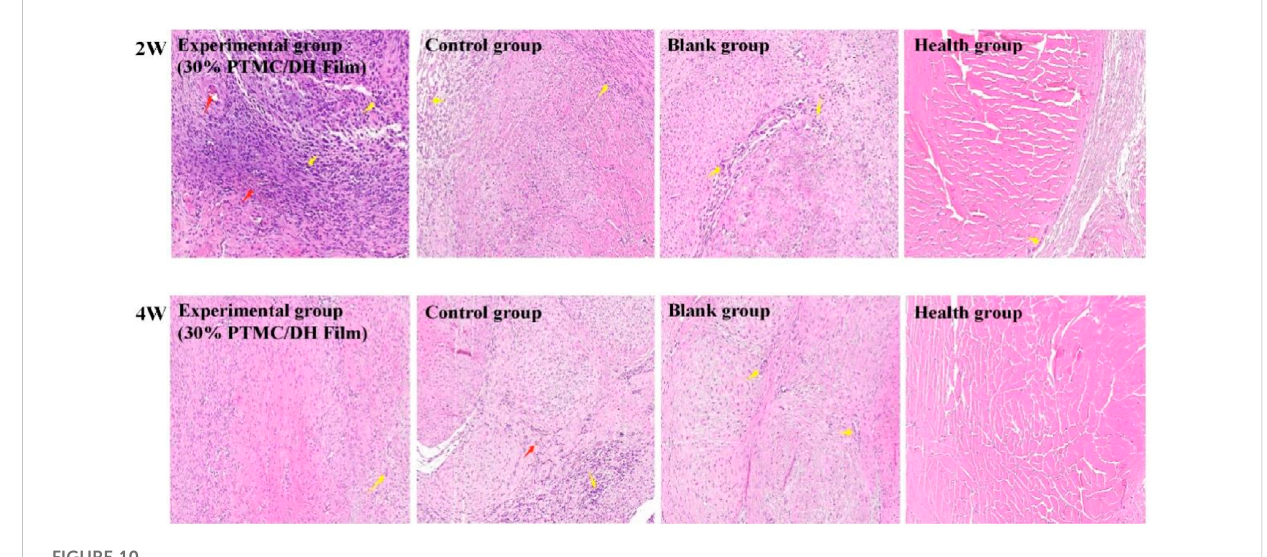
FIGURE 10 Histology of the rat Achilles tendon at 2 weeks and 4 weeks postoperatively (Red arrows show neovascularization, Yellow arrows show in fl ammatory cells).